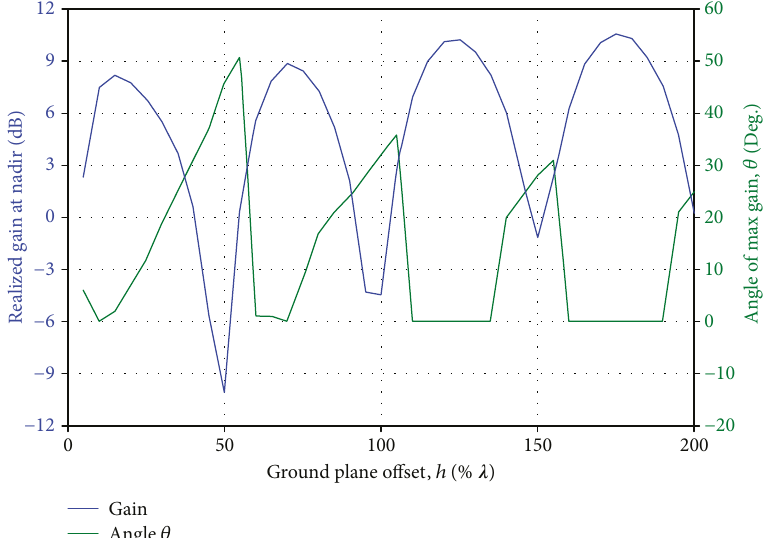
Figure 17: Ground plane o ff set up to 2 wavelengths versus realized gain at nadir and angle of maximum gain for all operating